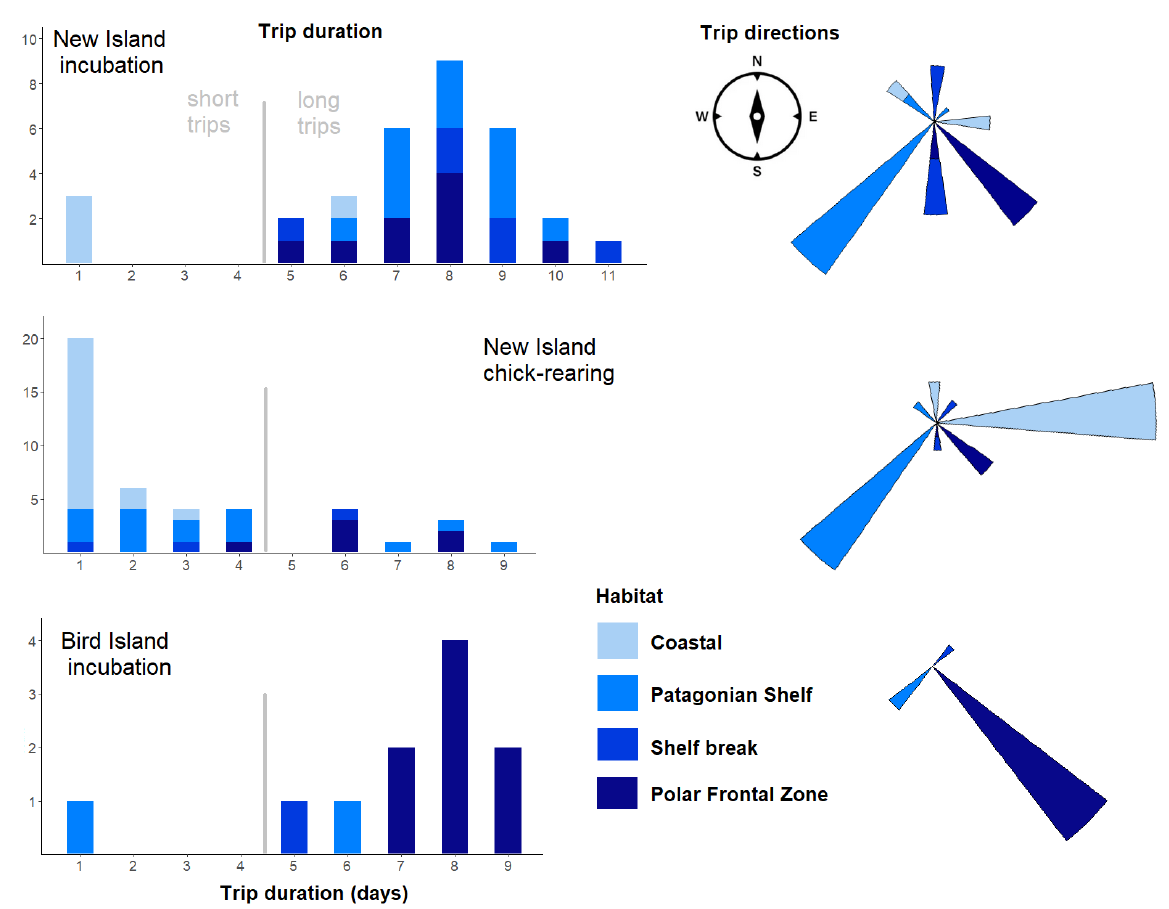
Figure 6. Habitat use of Thin-billed Prions from two colonies in the Falkland Islands, separately for the breeding stages. For a definition of the foraging areas, see Figure 1 and Table 2.